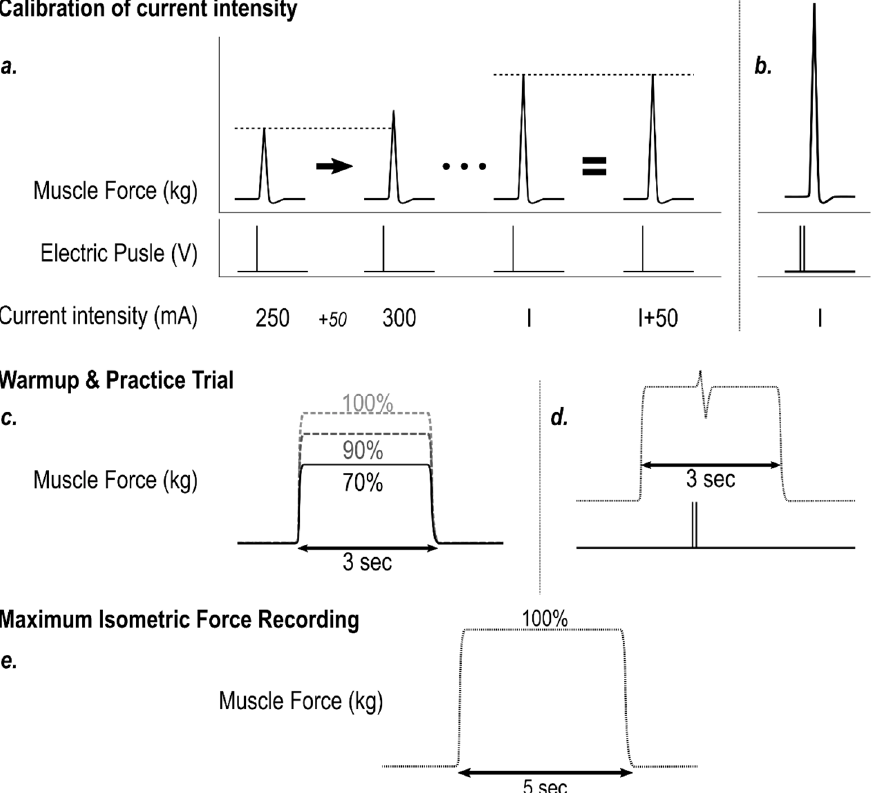
Figure 2. Calibration and warmup procedure for the superimposed twitch technique. ( a ). Starting at 250 mA, a single pulse is triggered, and force is recorded. Amperage is increased in 50 mA incre- ments until force plateaus. All motor units are now considered recruited. The before-last amperage (I) is used for the experiment. ( b ). The actual trial employs double twitch. Tolerance to pain and discomfort is confirmed by the participant. ( c ). Warm up trials at the participant’s perceived 70%, 90%, and 100%. ( d ). Practice trial. ( e ). 5-s maximum isometric voluntary contraction. The highest 3- s average is extracted. The threshold for valid trials is 90% of this 3-s maximum